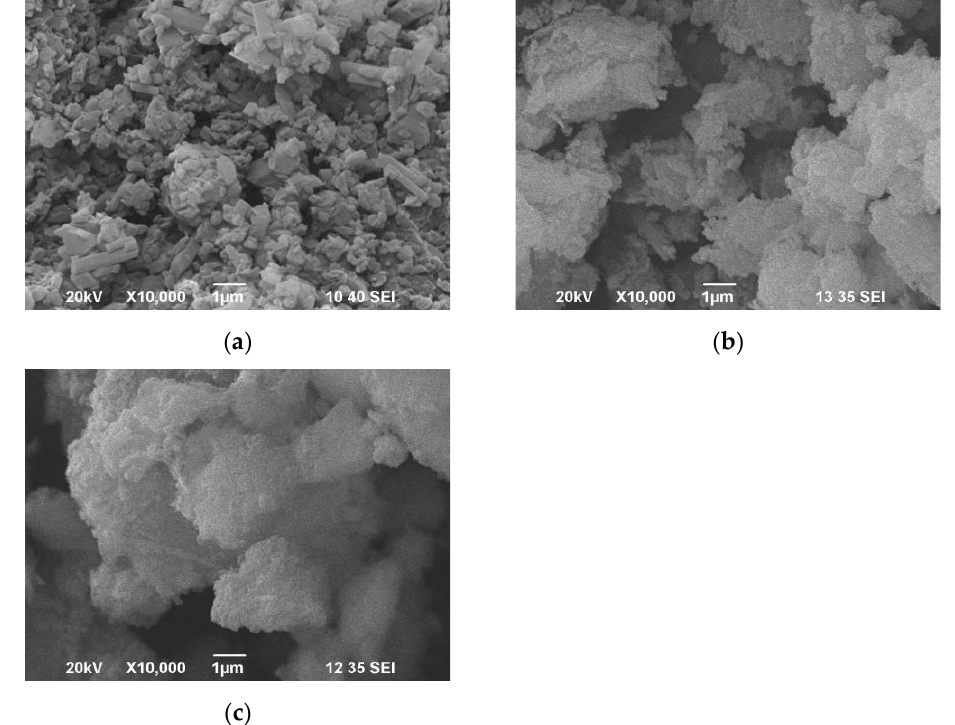
Figure 1. SEM images of pure HNT ( a ), PP-HNT ( b ) and G-HNT ( c ).